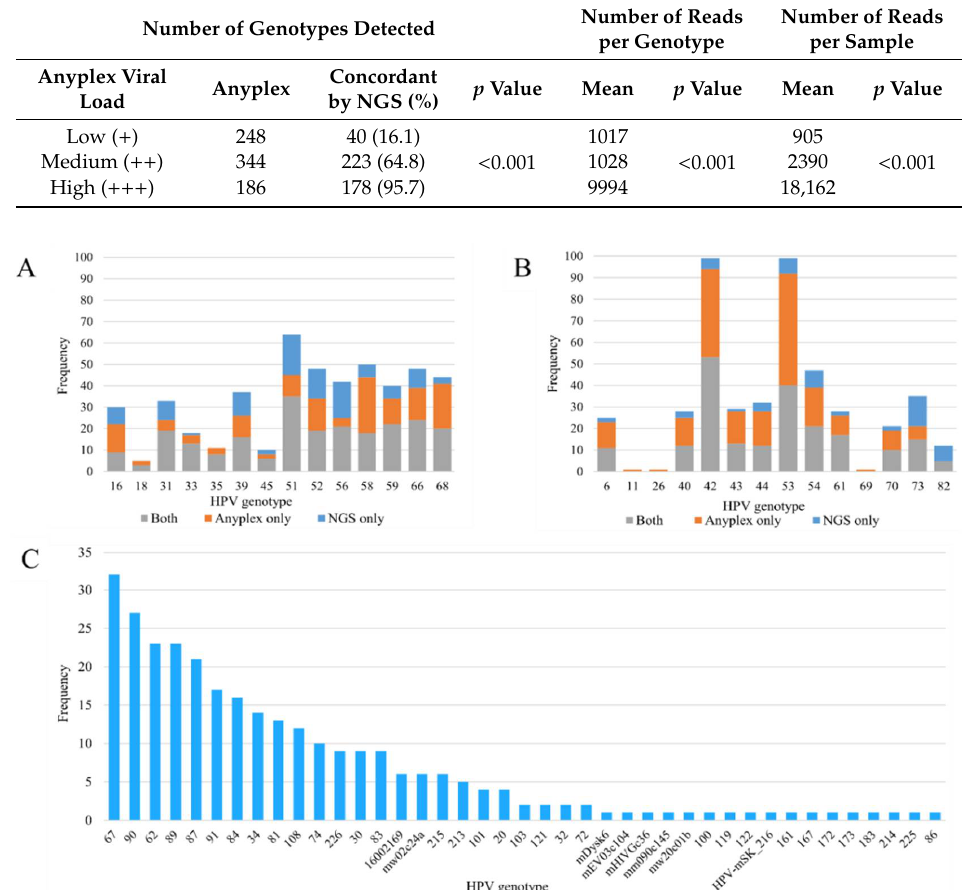
Table 2. Overall agreement for HPV detection between Anyplex II HPV28 and next-generation sequencing.